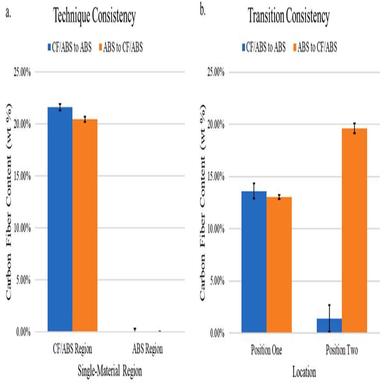
Average carbon fiber content of three consecutive samples for four locations from each transition direction. a. The single-material regions. b. The transition region.